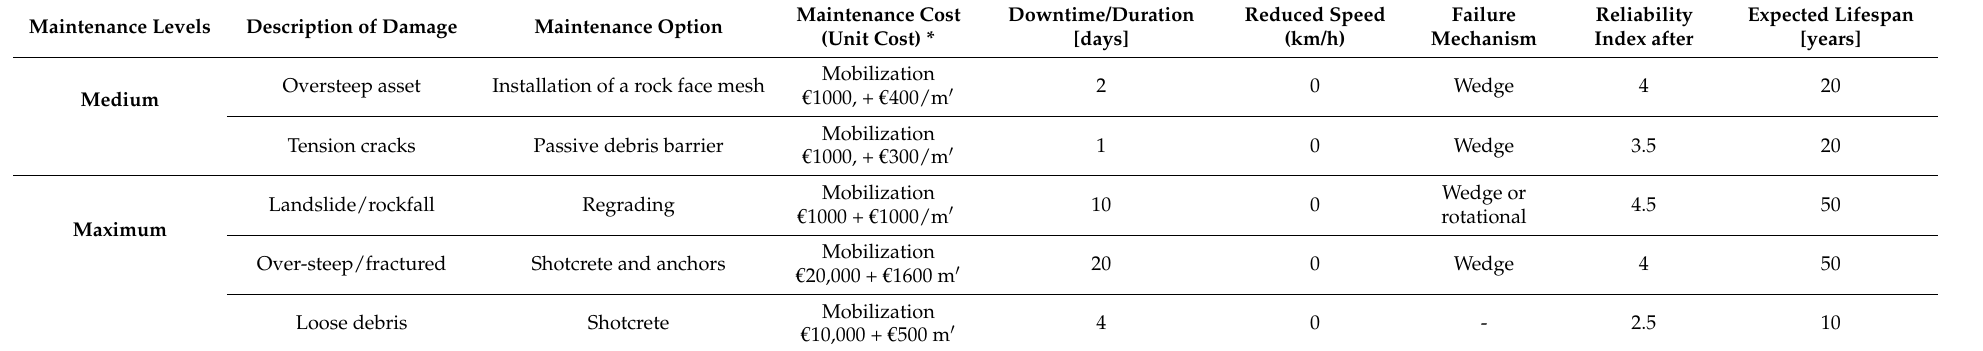
Table 2. Intervention rules for rock